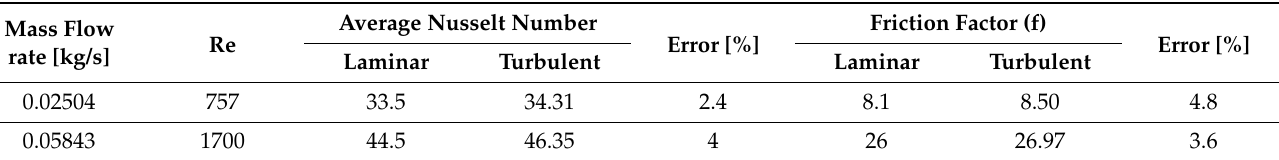
Table 3. Comparison results between turbulent and laminar flow regimes at two different Reynolds numbers.